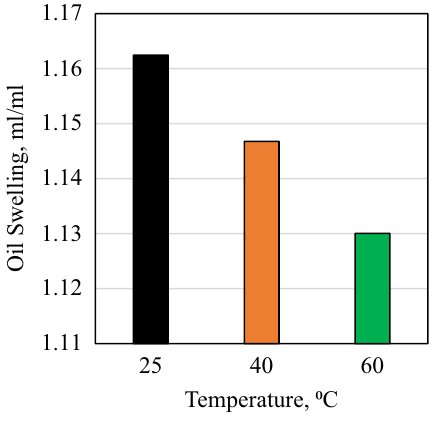
Fig. 2 Effect of CO 2 injection pressure on oil swelling at 40 °C using 1 ml of 460 cp oil